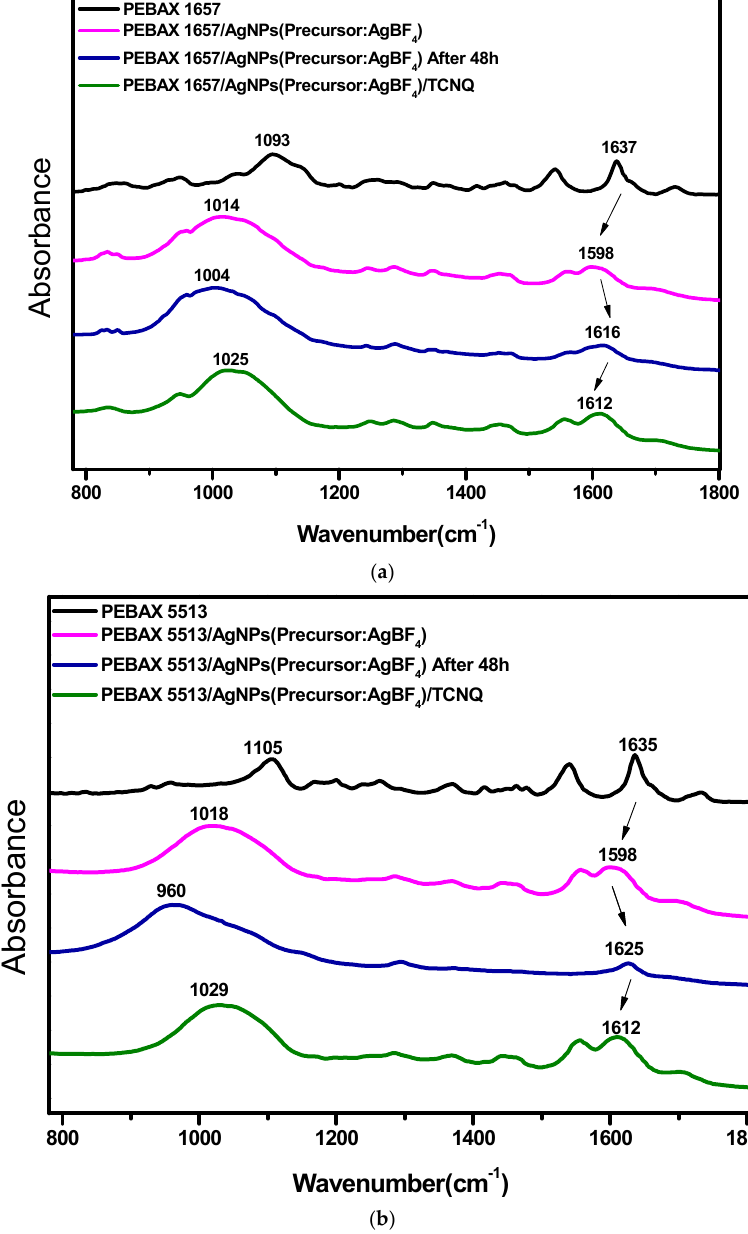
Figure 3. FT-IR spectra of ( a ) PEBAX-1657 and ( b ) PEBAX-5513 composites. For the case of the polyether group, when AgNPs generated from AgBF 4 and TCNQ were integrated into the PEBAX-1657 membrane, the peak of the wavenumber shifted